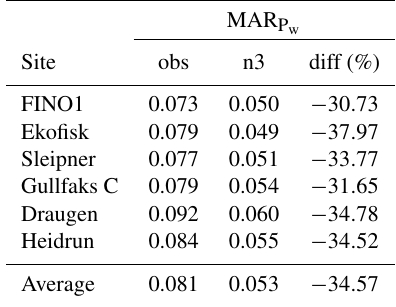
) for the normalized w w is given in percentage w